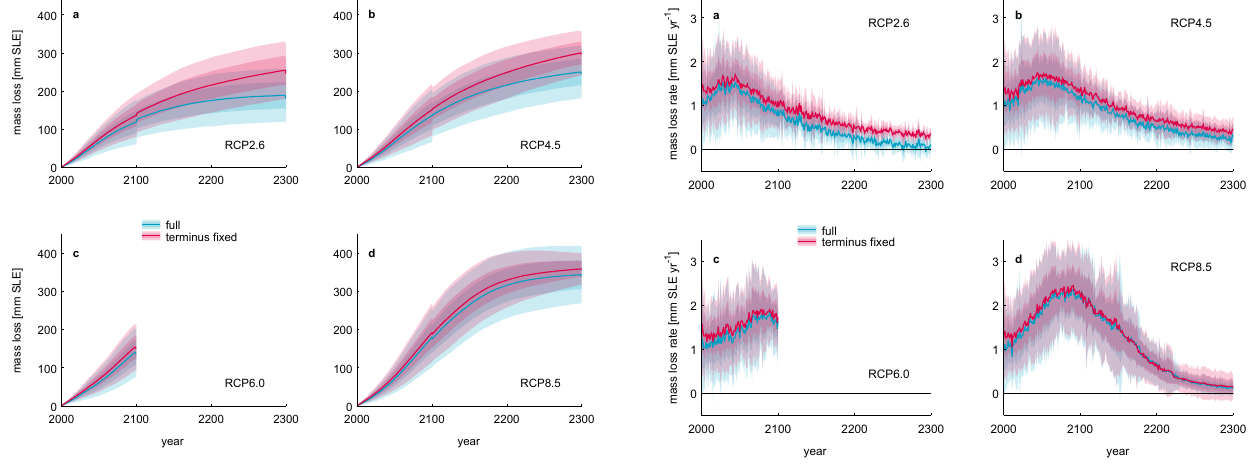
Fig. 10. Effect of fixed glacier terminus altitude on glacier mass change rates; “full” refers to the results of Marzeion et al. (2012) with fully responsive glacier hypsometry. Solid line is ensemble mean, dark/light shading indicates ensemble spread (one/two stan- dard deviations). Different panels refer to different RCPs.